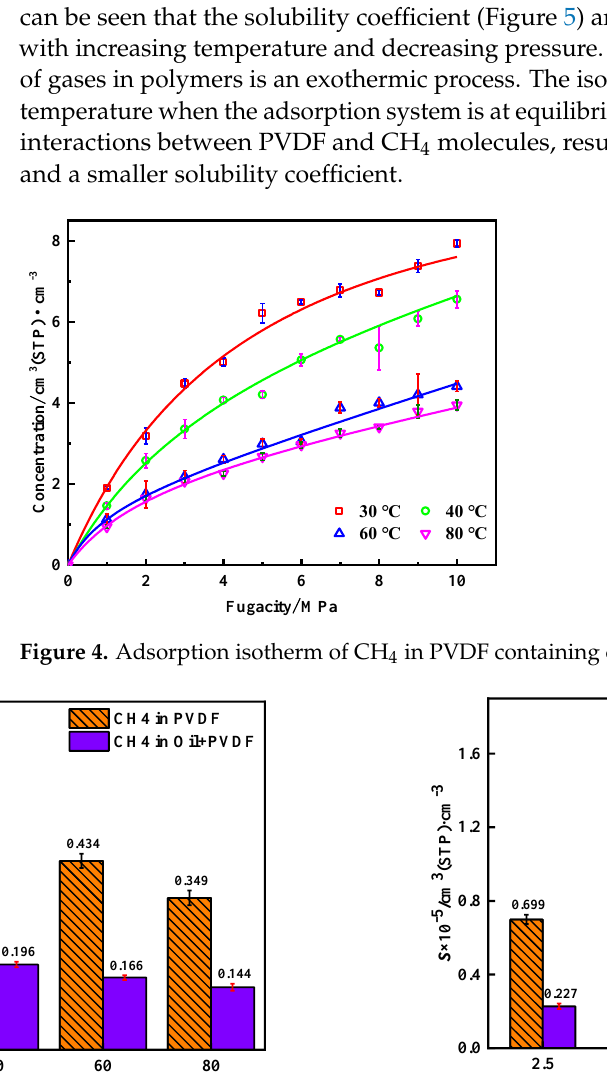
Figure 5. Solubility coefficient of CH 4 in PVDF at different conditions: ( a ) 2.5 MPa; ( b ) 30 °C.